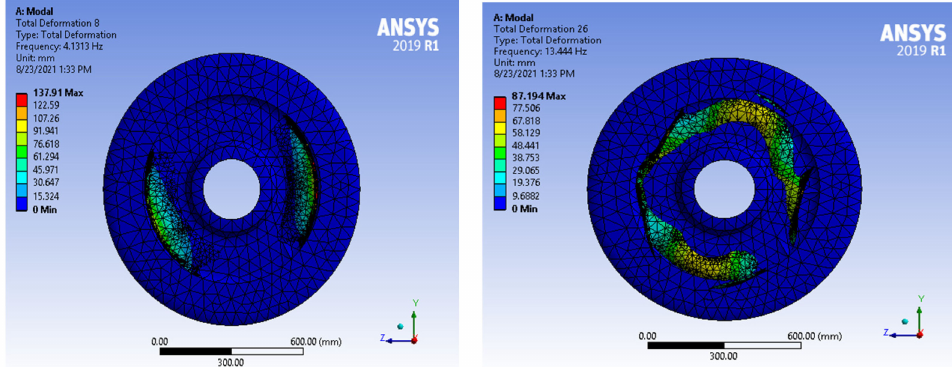
Figure A3. Mode shapes of the wheel mounted with viscoelastic damping layer on the web and under the rim of both sides when it starts to experience high amplitudes. The wheel with the viscoelastic damping layer situated around the light blue color code of the deformed shape displaced the least. It is clear that node 10 will experience less deformation compared with the wheel without the viscoelastic damping layer, since the light blue color dominates the color legends on the wheel.